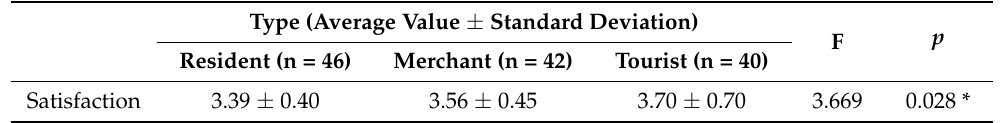
Table 3. Variance Analysis of the Overall Satisfaction of All Subjects.